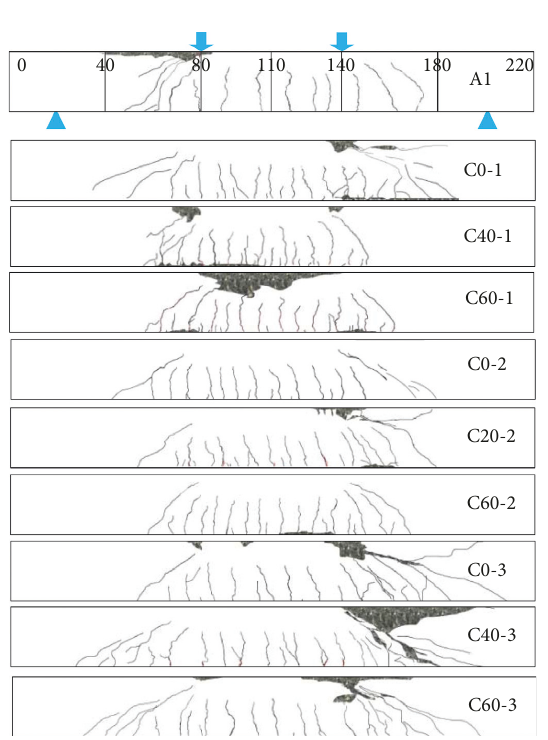
Figure 10: Distribution maps of